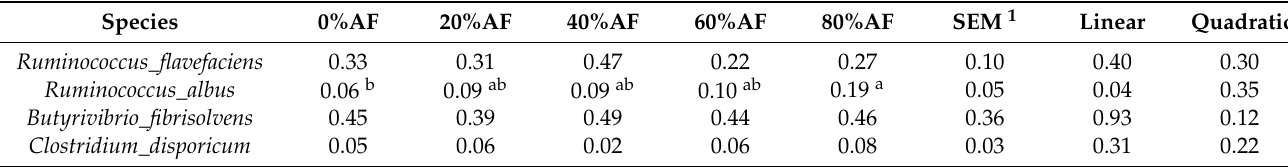
Table 7. The relative abundance of rumen bacterial